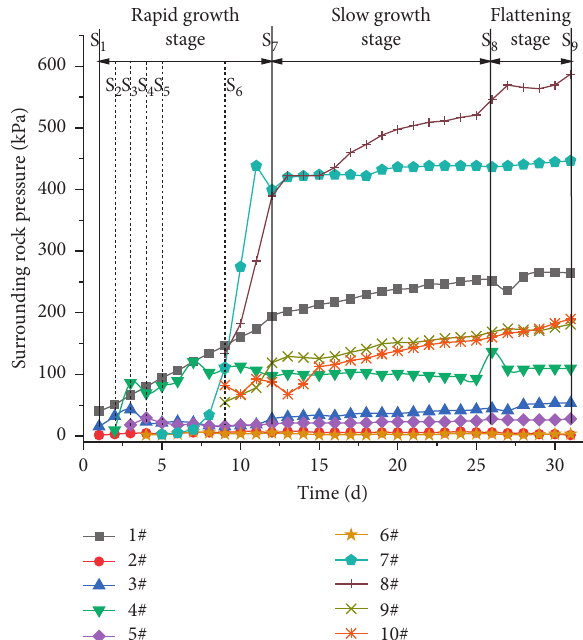
Figure 6: Pressure change curve of surrounding rock of DK- 190+645 miles in early three